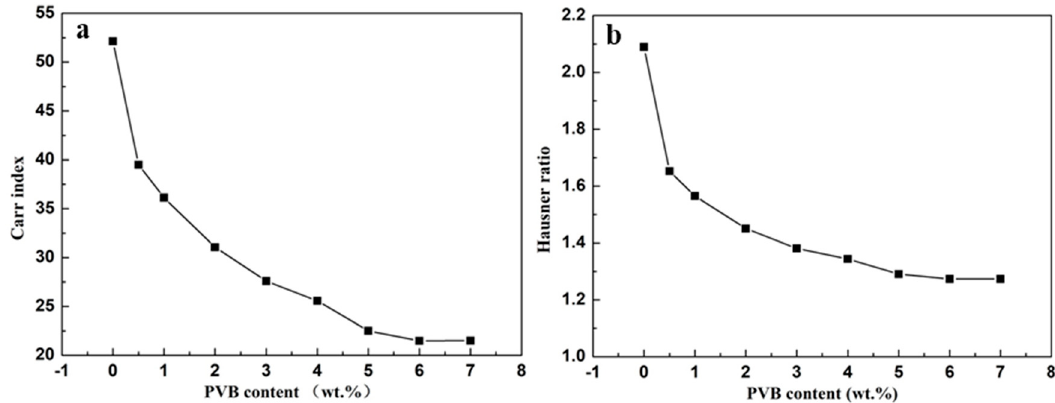
Figure 6. The Carr index ( a ) and Hausner ratio ( b ) of SiC/PVB composite powders with different PVB